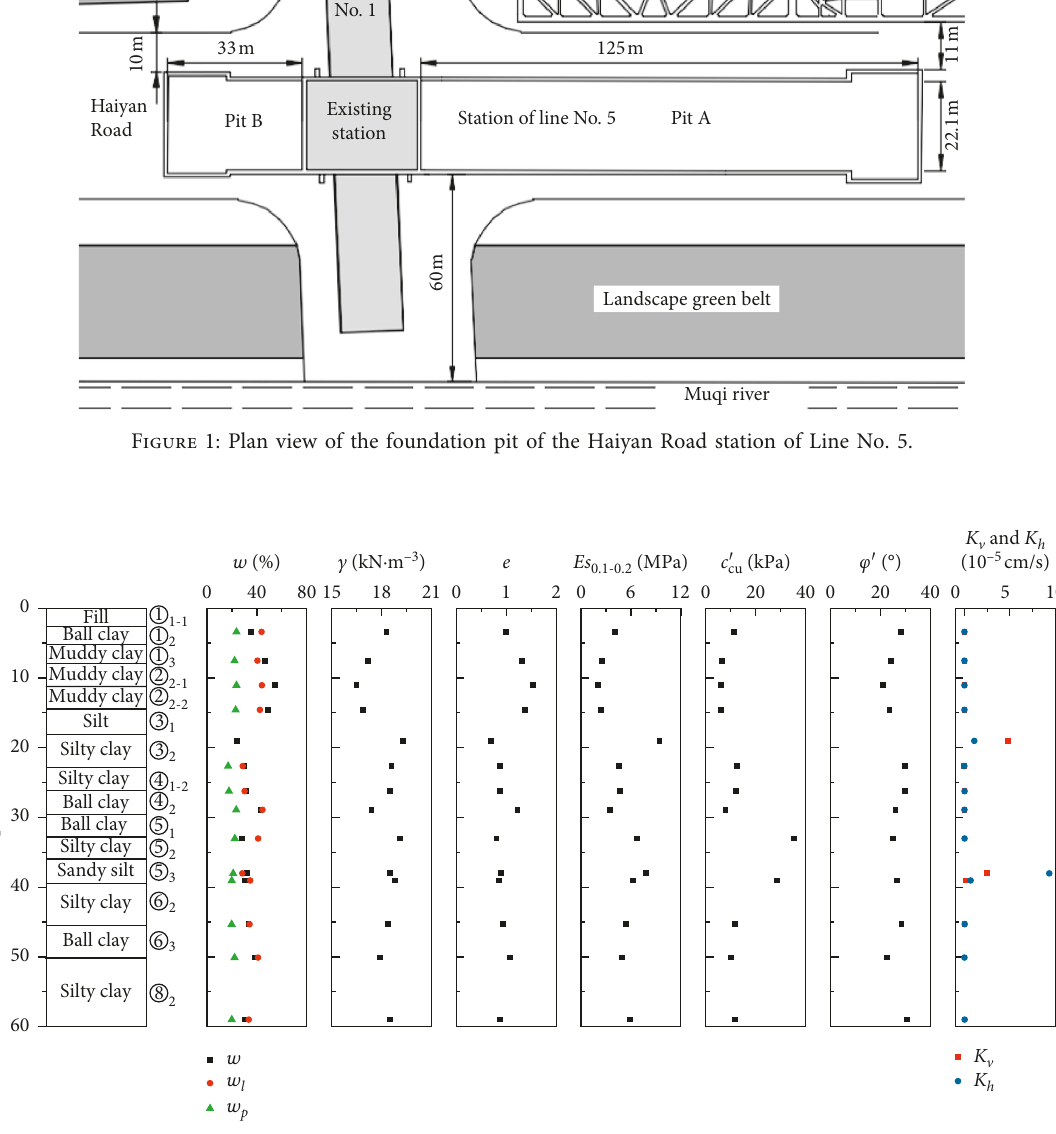
w c —soil gravity; l —liquid limit; p —plastic limit; ′ —effective stress friction angle; e —porosity; K v —vertical perme- cu